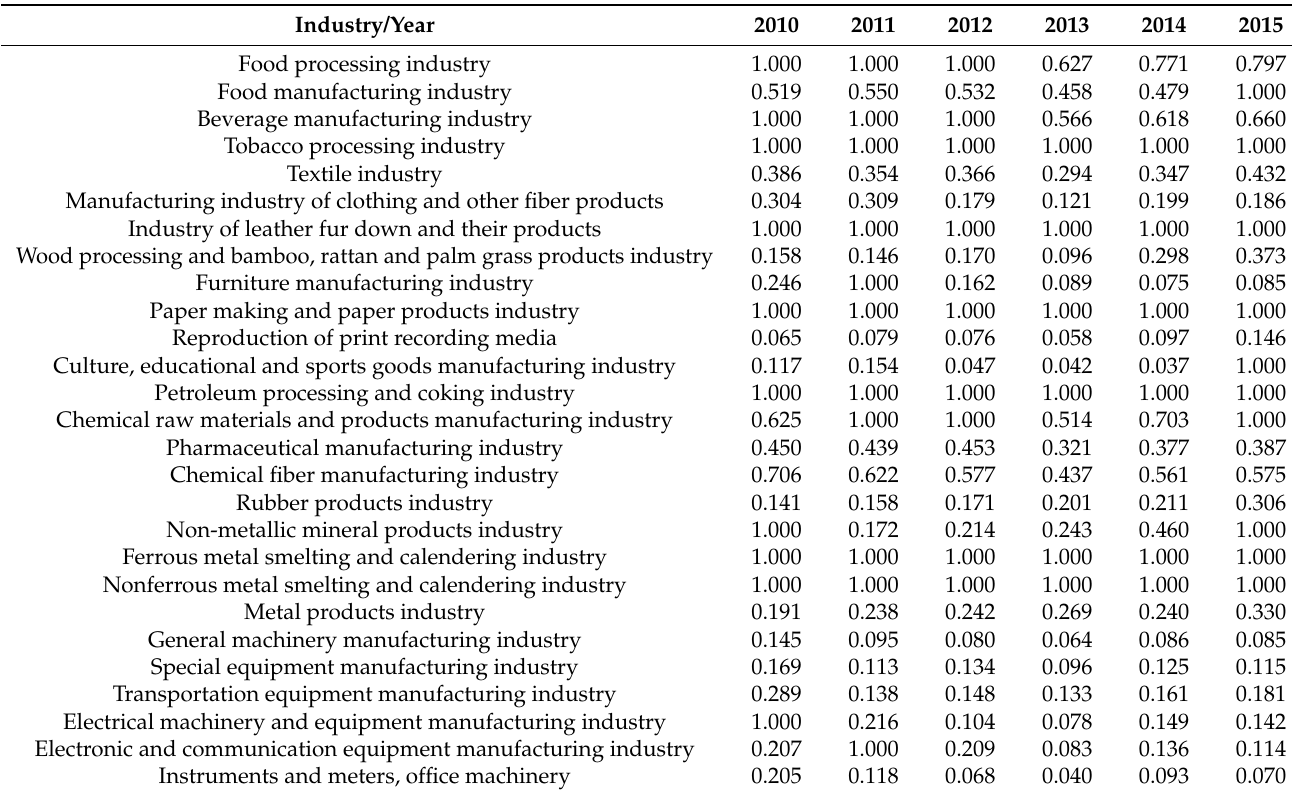
Table 2. GTFP of various